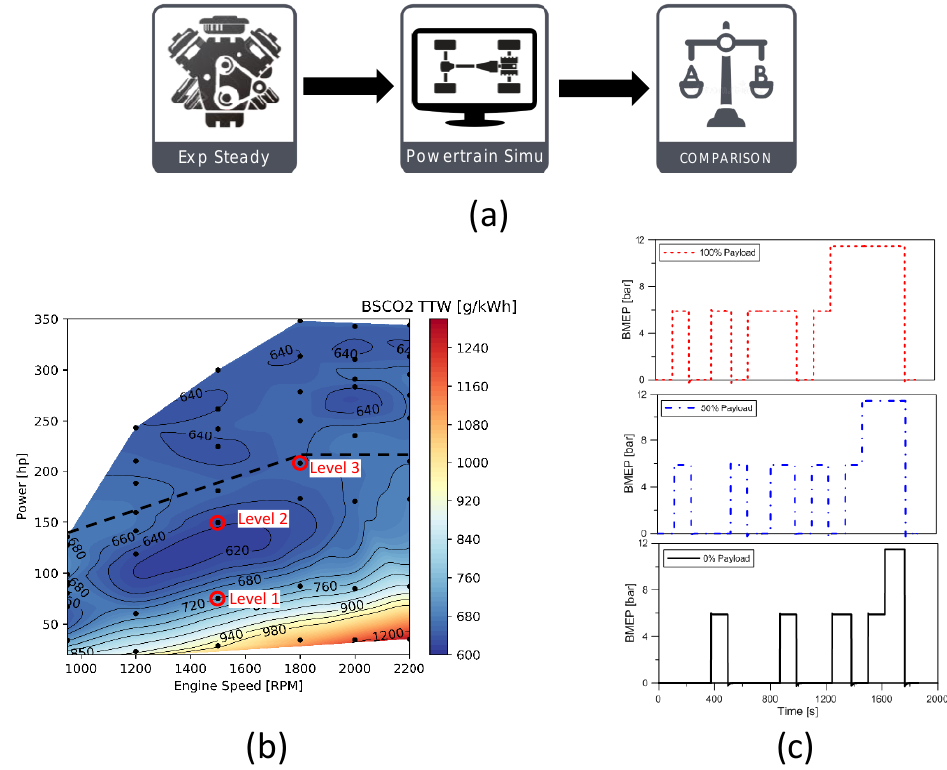
Figure 9. Scheme of the methodology applied in the current manuscript ( a ), the engine map with the operation conditions ( b ), and the load vs. time under several payloads 0%, 50% and 100% ( c ) in series hybrid.